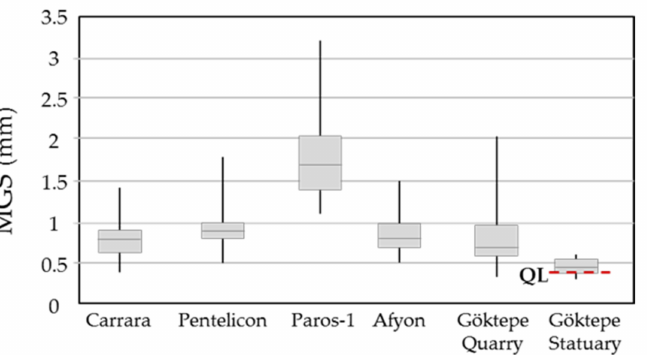
Figure 5. Maximum Grain Size of the white fine-grained marble. The dashed red line (MGS of 0.4 mm in sample QL) is in the 25th percentile of data measured in lithotype G identified in pieces of Villa Adriana